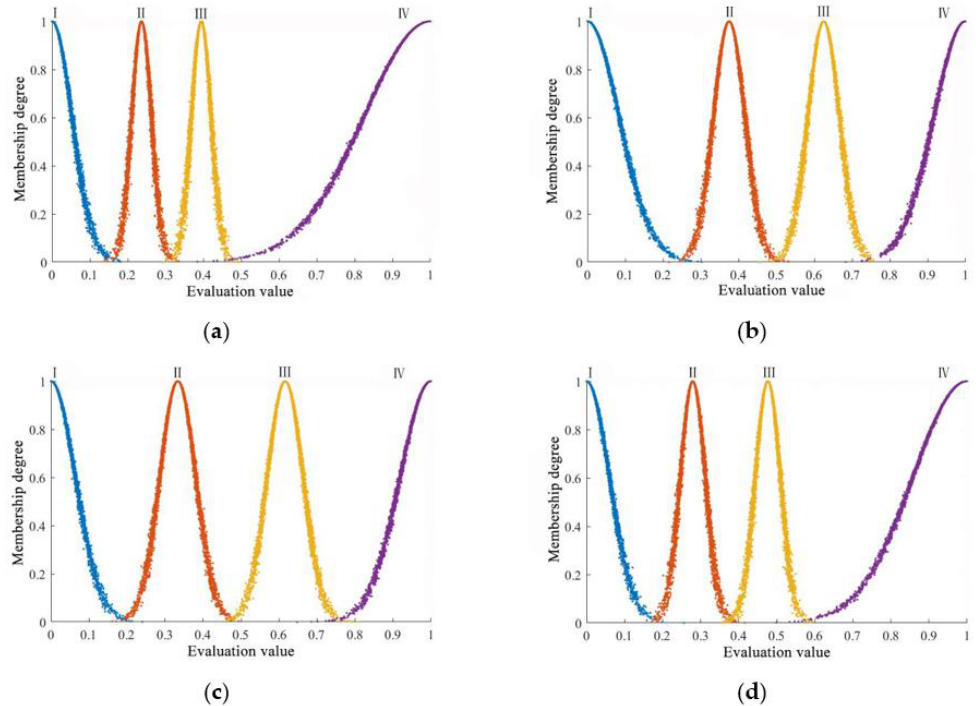
Figure 4. Comprehensive standard cloud model of four indexes in criterion level: ( a ) Support conditions; ( b ) Roof conditions; ( c ) Personnel working status; ( d ) Coal body status.